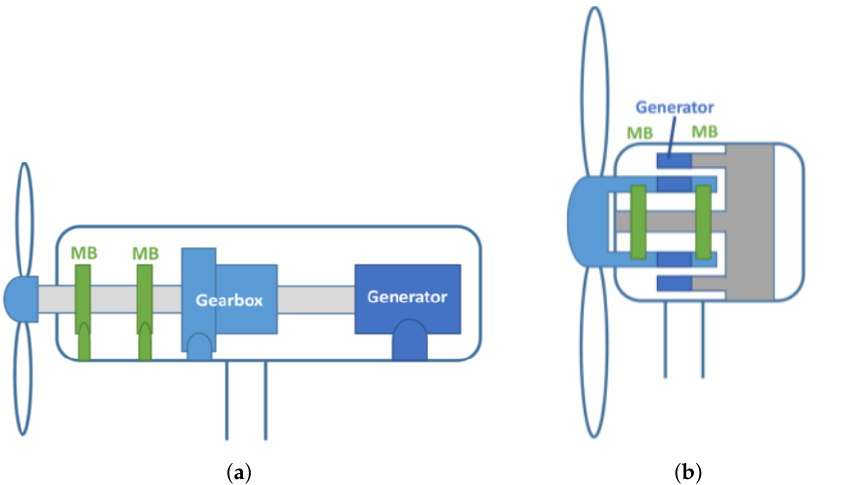
Figure 2. Drivetrain layout assumed for the drivetrain technologies under consideration in this paper (adopted from [28]). ( a ) Four-point suspension (geared), ( b ) Three-point suspension (direct-drive).